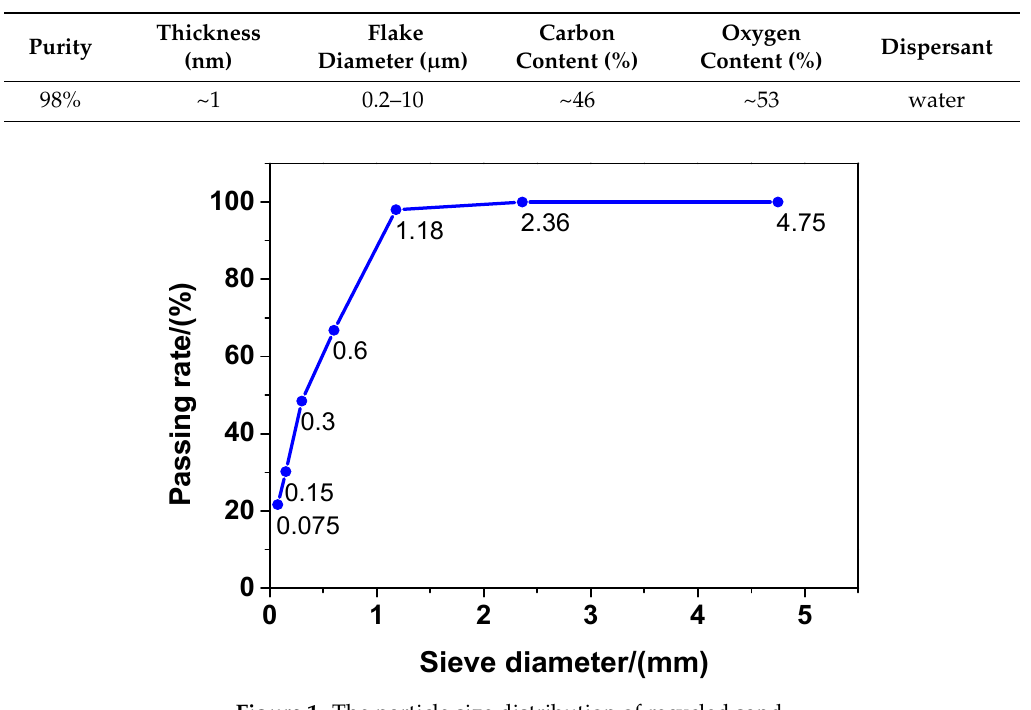
Table 2. The physical properties of the fine recycled sand. Table 3. The physical and chemical properties of graphene oxide (GO).